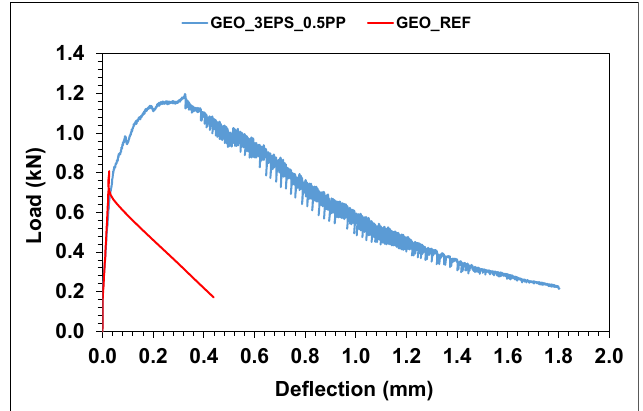
Figure 8. Load-deflection curves for the reference and the reinforced products.